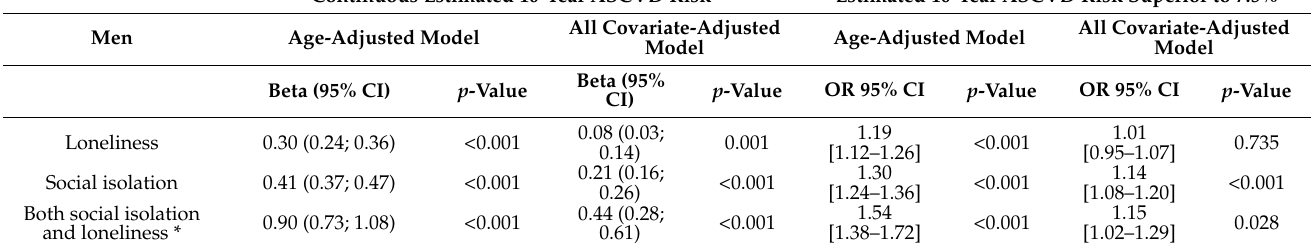
Table 2. Multiple linear and logistic regression models for estimated 10-year ASCVD risk among men (all covariates adjusted: age, education, income level, physical activity, couple, antidepressant medication, Townsend deprivation index, BMI, triglycerides, and CKD). The reference was the reference group.